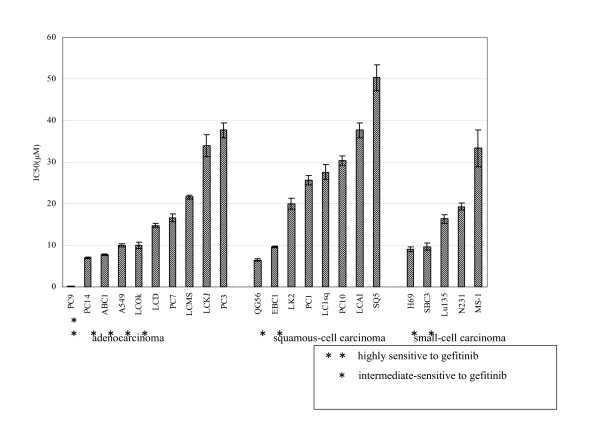
IC50 values for 23 lung cancer cell lines using the MTT assay. Cell lines were classified as: sensitive (IC50≤1 μM), intermediate-sensitive (1 μM < IC50≤10 μM), and resistant (10 μM <IC50) to gefitinib. The bars represent the IC50 and standard deviation (SD) obtained in three indpendent MTT assays. Point: mean of three independent experiments, bar: ± SD.